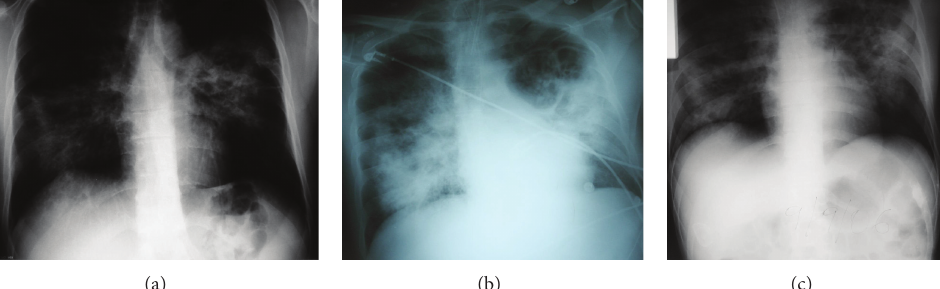
Figure 1: (a) Chest X-ray on admission with diffuse bilateral infiltrates. (b) 2 weeks after admission, intubated, receiving TMP/SMZ plus broad-spectrum antibiotics, after a 5-day immunoglobulin infusion course. First appearance of ground glass opacification and cystic/bullous lesions. Pseudomonas aeruginosa isolated from blood cultures. (c) 3.5 weeks after admission, short term clinical